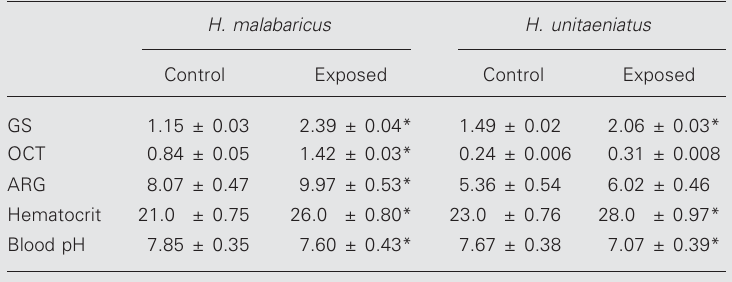
Enzyme activities are reported as means ± SD in µmol min -1 g protein -1 for N = 6 fish. *P<0.05 compared to control (Mann-Whitney